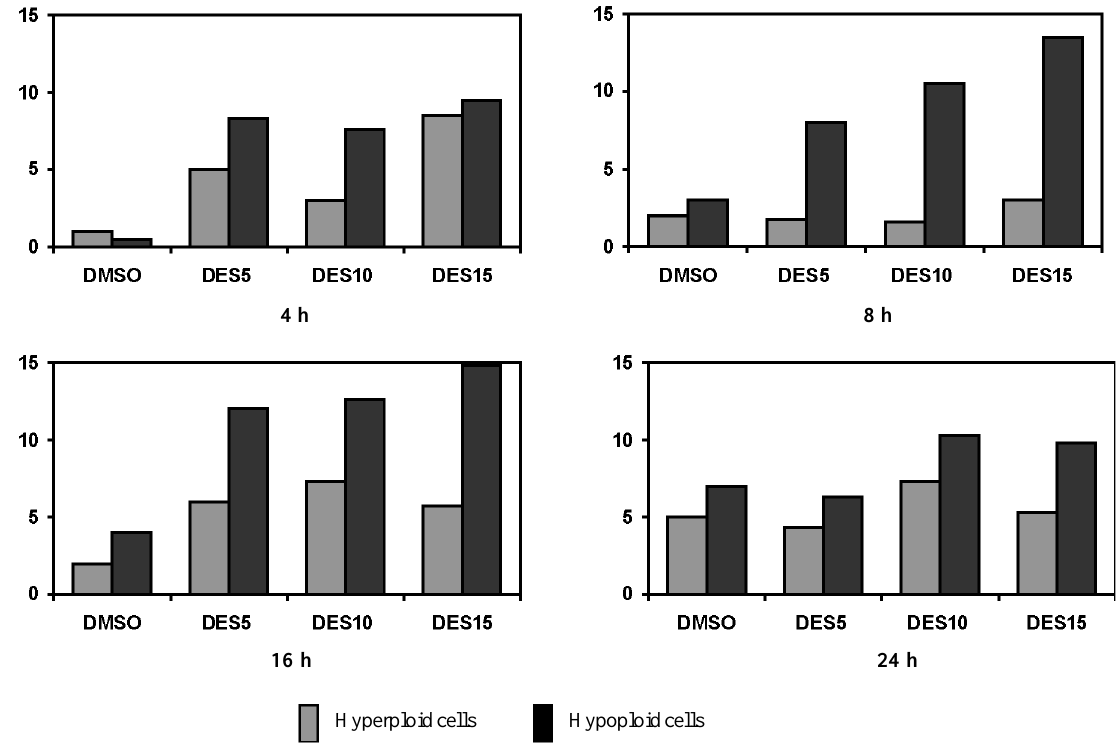
Figure 3 - Percentages of hypoploid and hyperploid CHED cells after treatment with diethylstilbestrol (DES) doses of 5, 10, and 15 µ g/ml for different